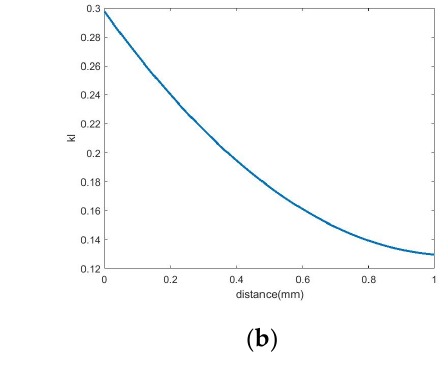
; ( b ) . ; ( b ) . 𝑘𝑘 𝑎𝑎 𝑘𝑘 𝑙𝑙 𝑘𝑘 𝑎𝑎 𝑘𝑘 𝑙𝑙